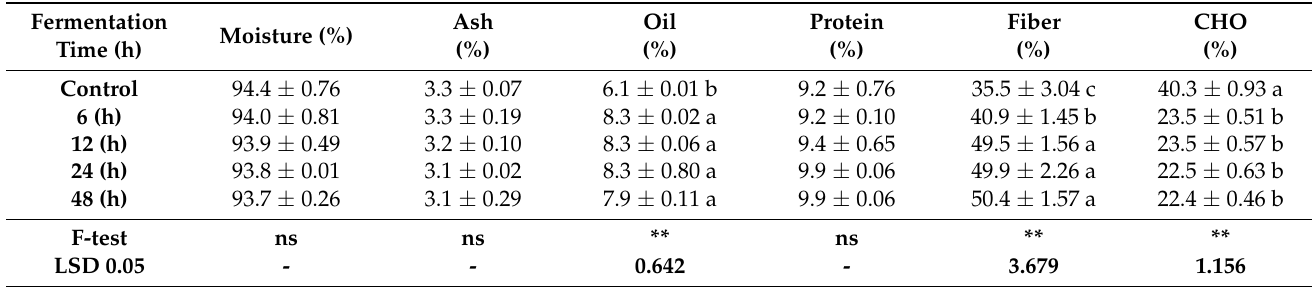
Table 1. Effect of natural fermentation on the proximate composition of “Nabag” ( Ziziphus spina-christi L.) seeds.